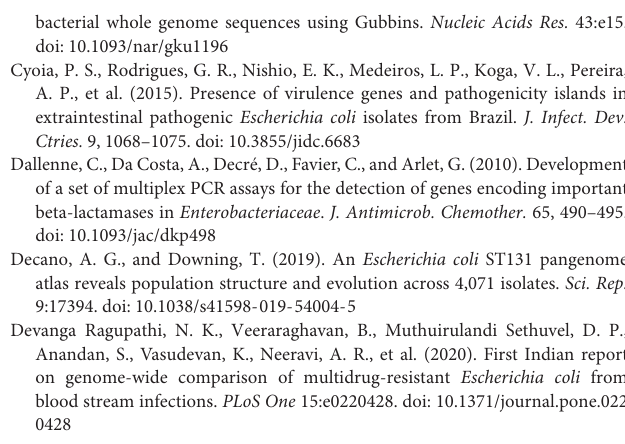
Supplementary Figure 1 | Pangenome matrix of 21 E. coli strains from Ghana. Supplementary Figure 2 | Pie chart representation of core and accessory genes identified in the genomes of 21 E. coli strains from